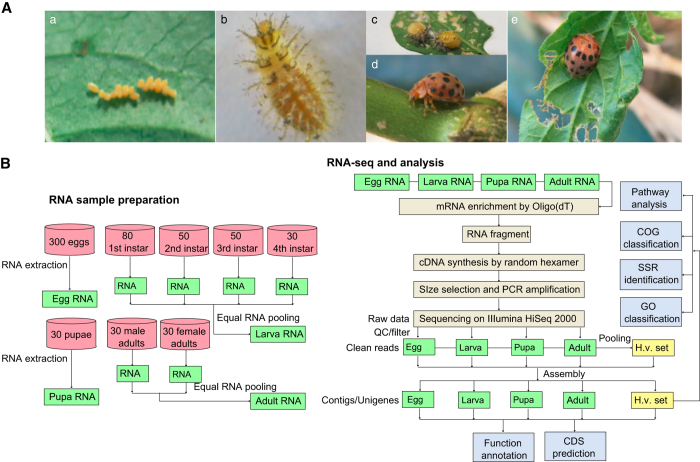
Four life stages of Henosepilachna vigintioctopunctata and a flowchart of the experiment.(a) eggs, (b) larva, (c) pupa, (d) male adult (e), and female adult.